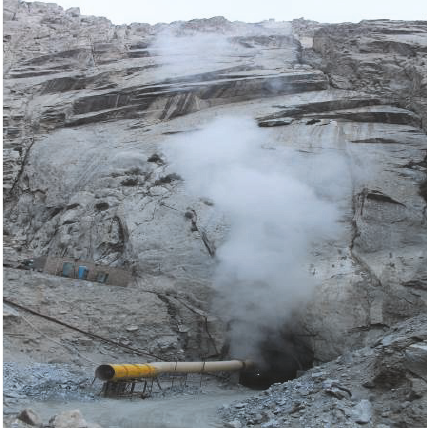
Figure 2: Water vapour gushing into the entrance [7].